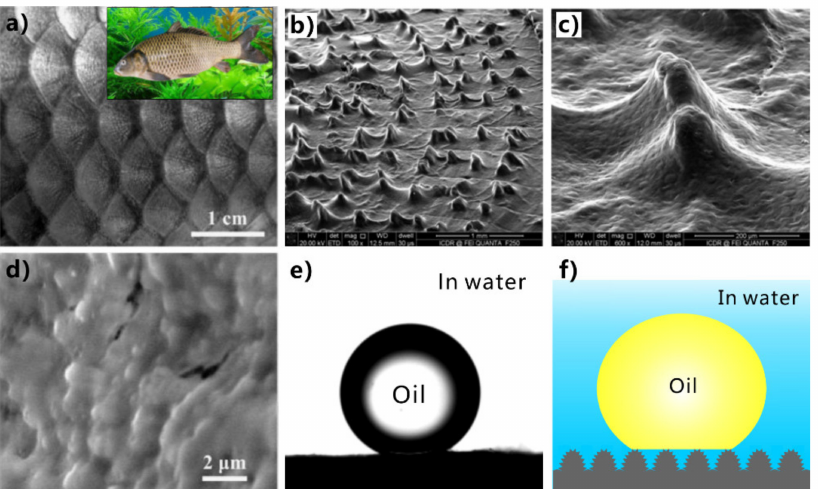
Figure 7. Underwater superoleophobicity of fish scales. ( a ) Photos of fish (inset) and fish scales. ( b – d ) Microstructures on the fish scales. ( e ) A drop of oil on the fish scale in water. ( f ) Schematic diagram of an oil droplet on the surface microstructures of the underwater superoleophobic fish scale in water. Reprinted with permission from ref. [49]. Copyright 2009, WILEY-VCH Verlag GmbH & Co. KgaA. Reprinted with permission from ref. [46]. Copyright 2017, American Chemical